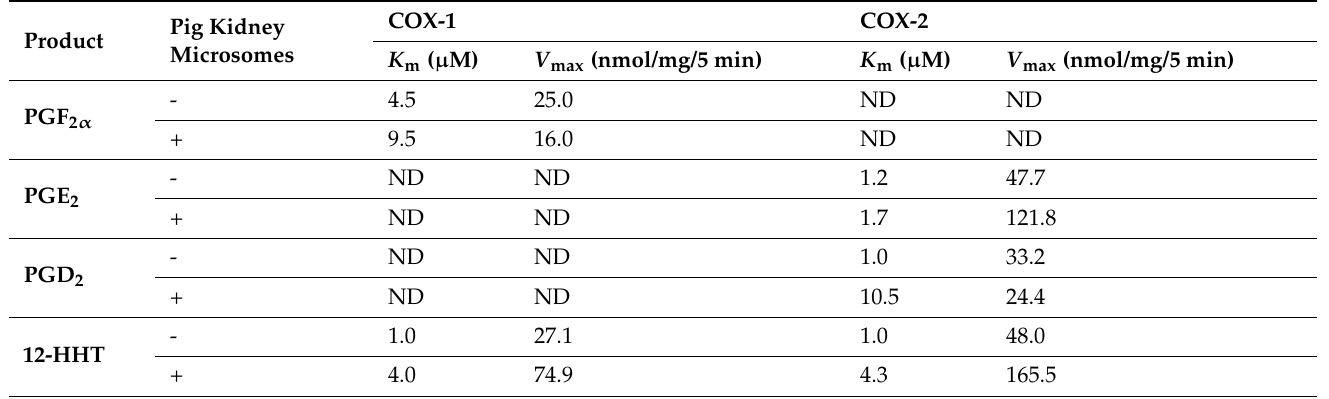
Table 1. Kinetic parameters ( K m and V max values) for COX-1/2-catalyzed formation of representative PG